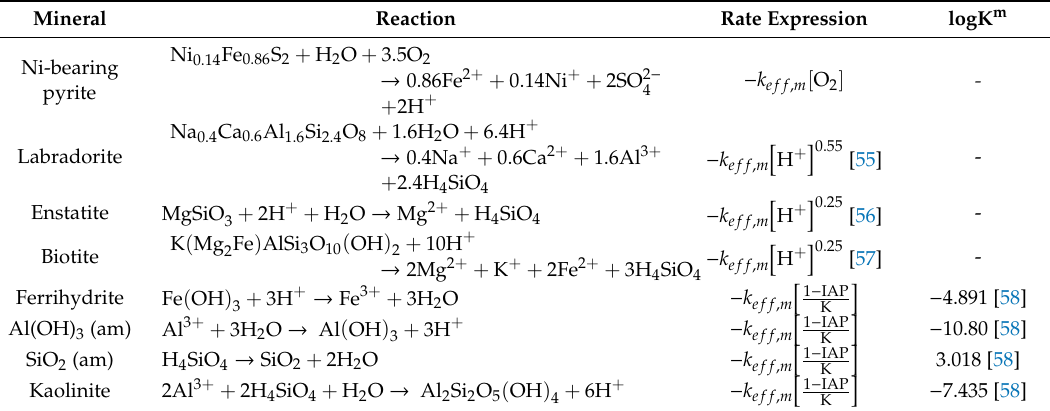
Table 4. Minerals and their dissolution–precipitation reactions considered in the numerical model. E ff ective rate constants ( k e ff ,m ) were calibrated depending on material zones and are presented in the results section in Table